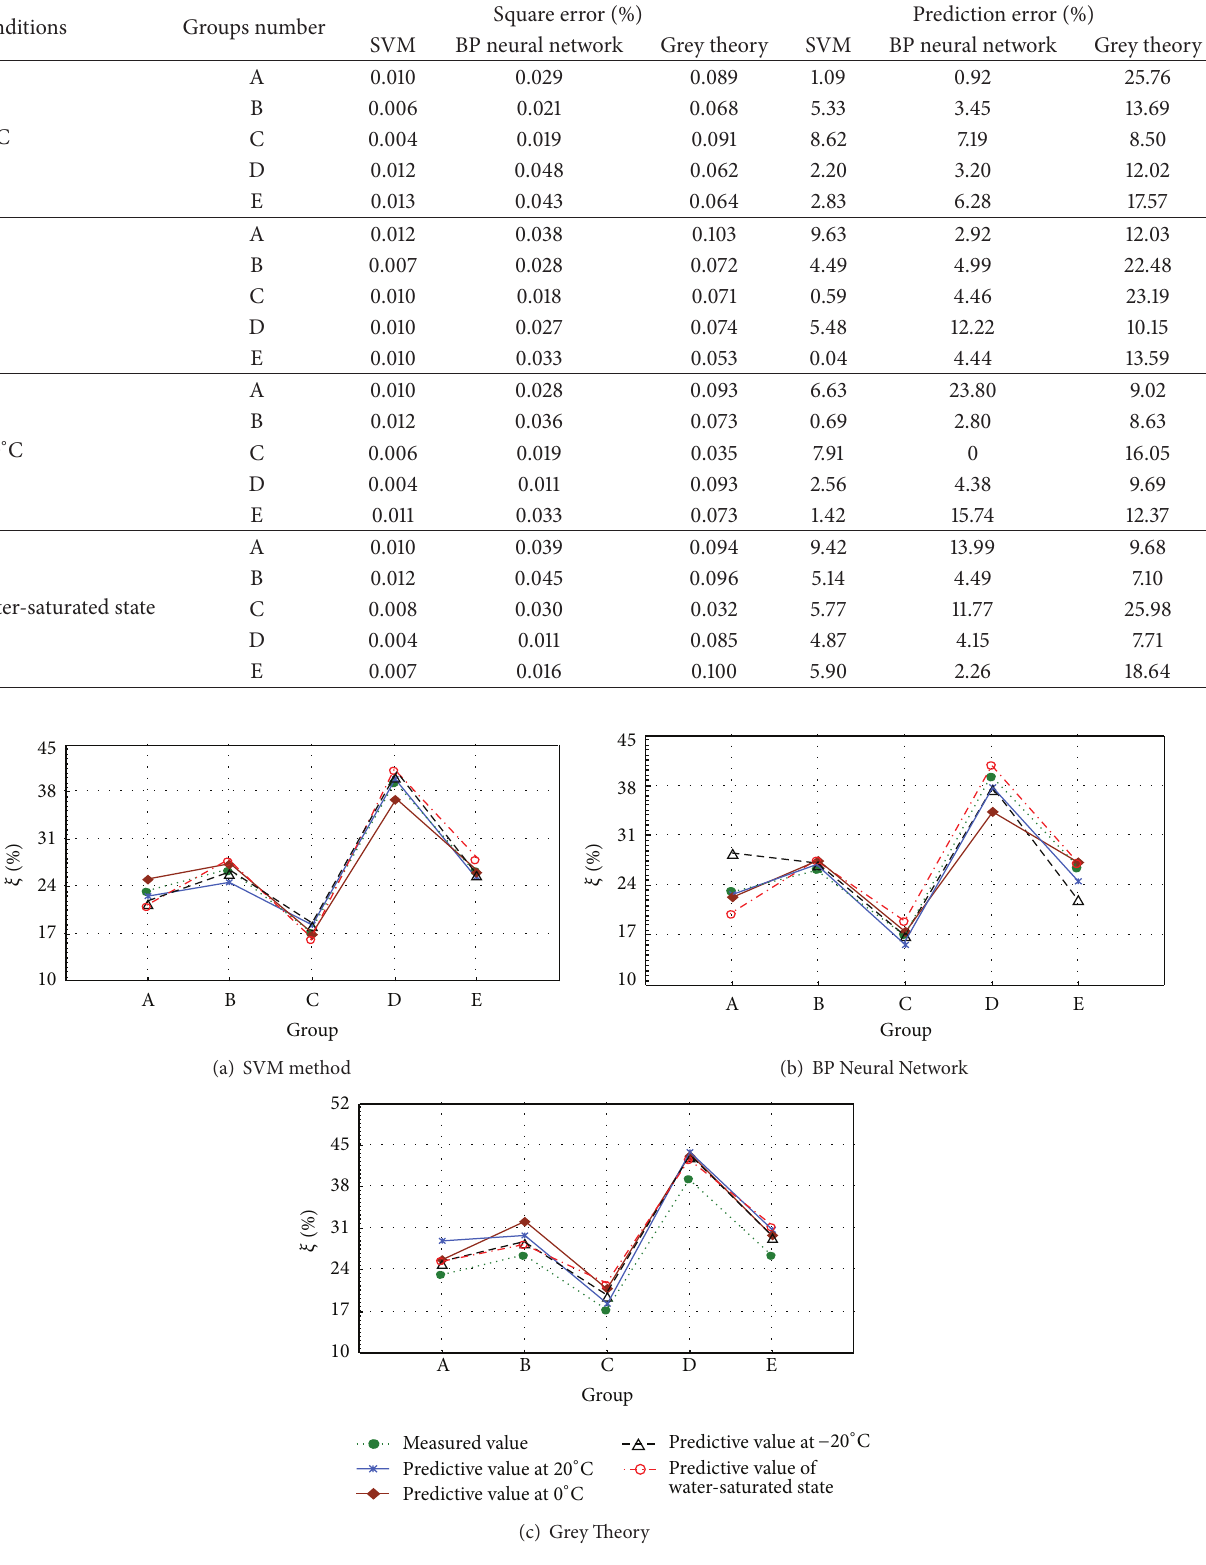
Figure 9: Comparison picture between prediction and actual